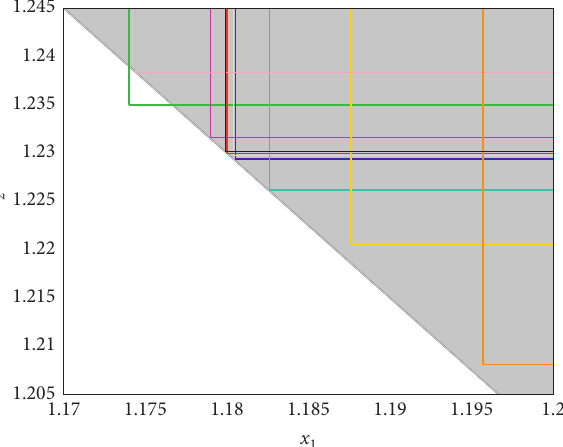
Figure 5: Magnification of region A in Figure 4.